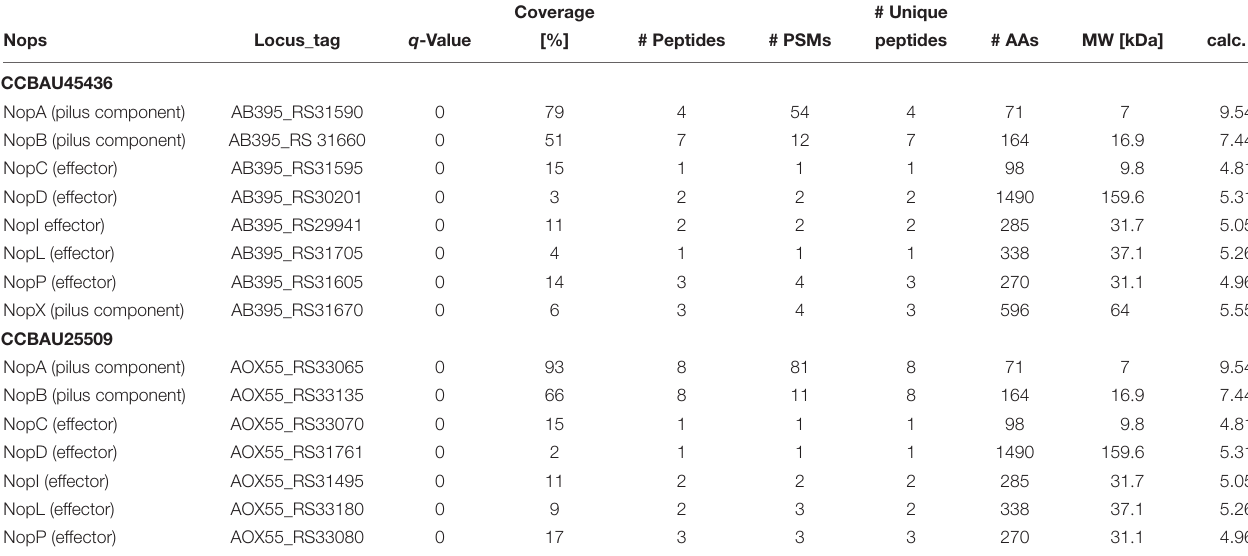
TABLE 1 | Orbitrap-based detection of Nops in CCBAU45436 and CCBAU25509 in response to genistein induction.